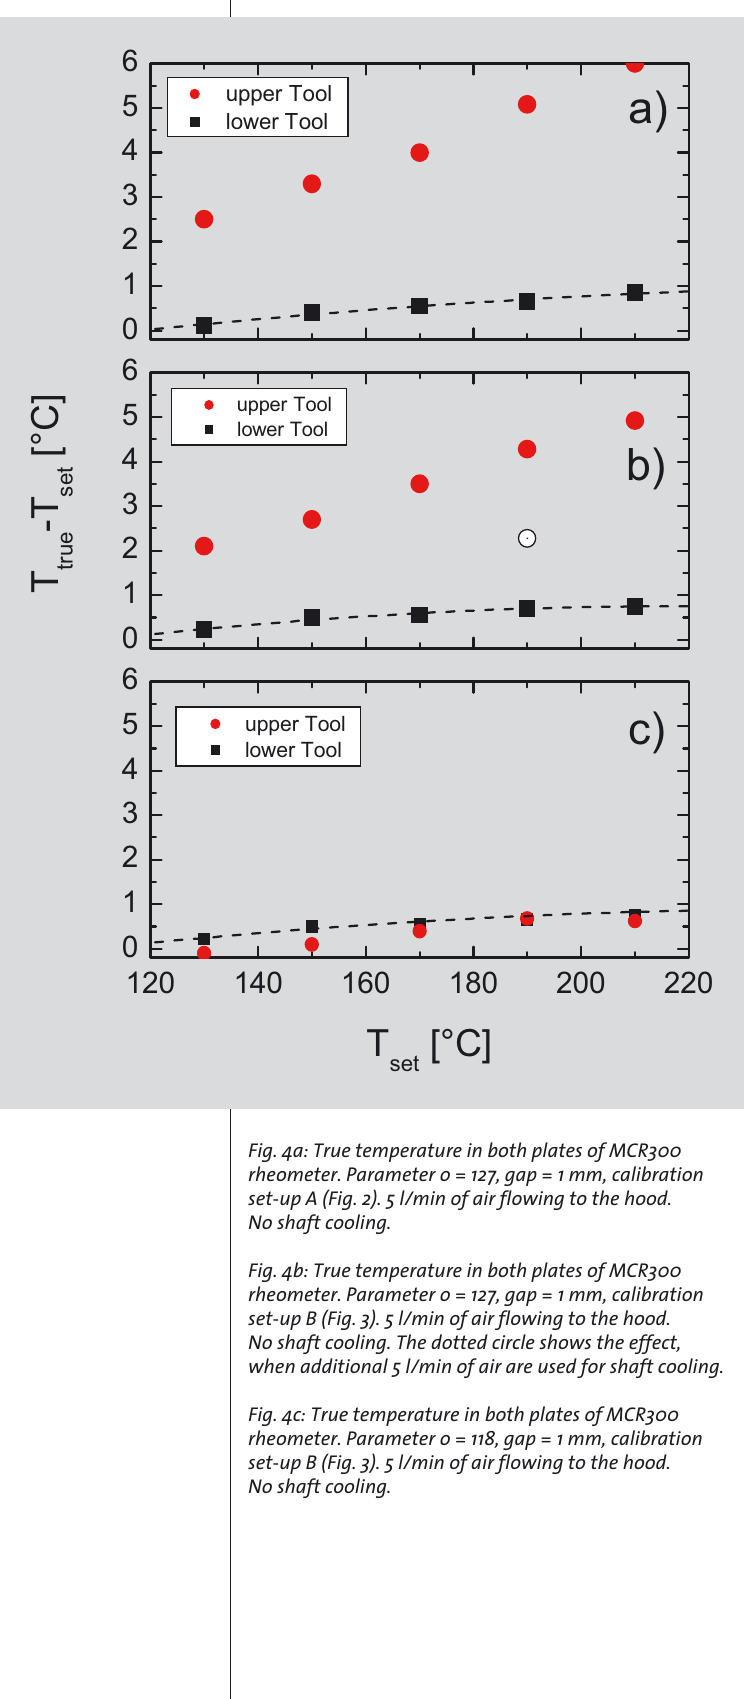
Fig. 4a: True temperature in both plates of MCR300 rheometer. Parameter o = 127, gap = 1 mm, calibration set-up A (Fig. 2). 5 l/min of air flowing to the hood. No shaft cooling. Fig. 4b: True temperature in both plates of MCR300 rheometer. Parameter o = 127, gap = 1 mm, calibration set-up B (Fig. 3). 5 l/min of air flowing to the hood. No shaft cooling. The dotted circle shows the effect, when additional 5 l/min of air are used for shaft cooling. Fig. 4c: True temperature in both plates of MCR300 rheometer. Parameter o = 118, gap = 1 mm, calibration set-up B (Fig. 3). 5 l/min of air flowing to the hood. No shaft